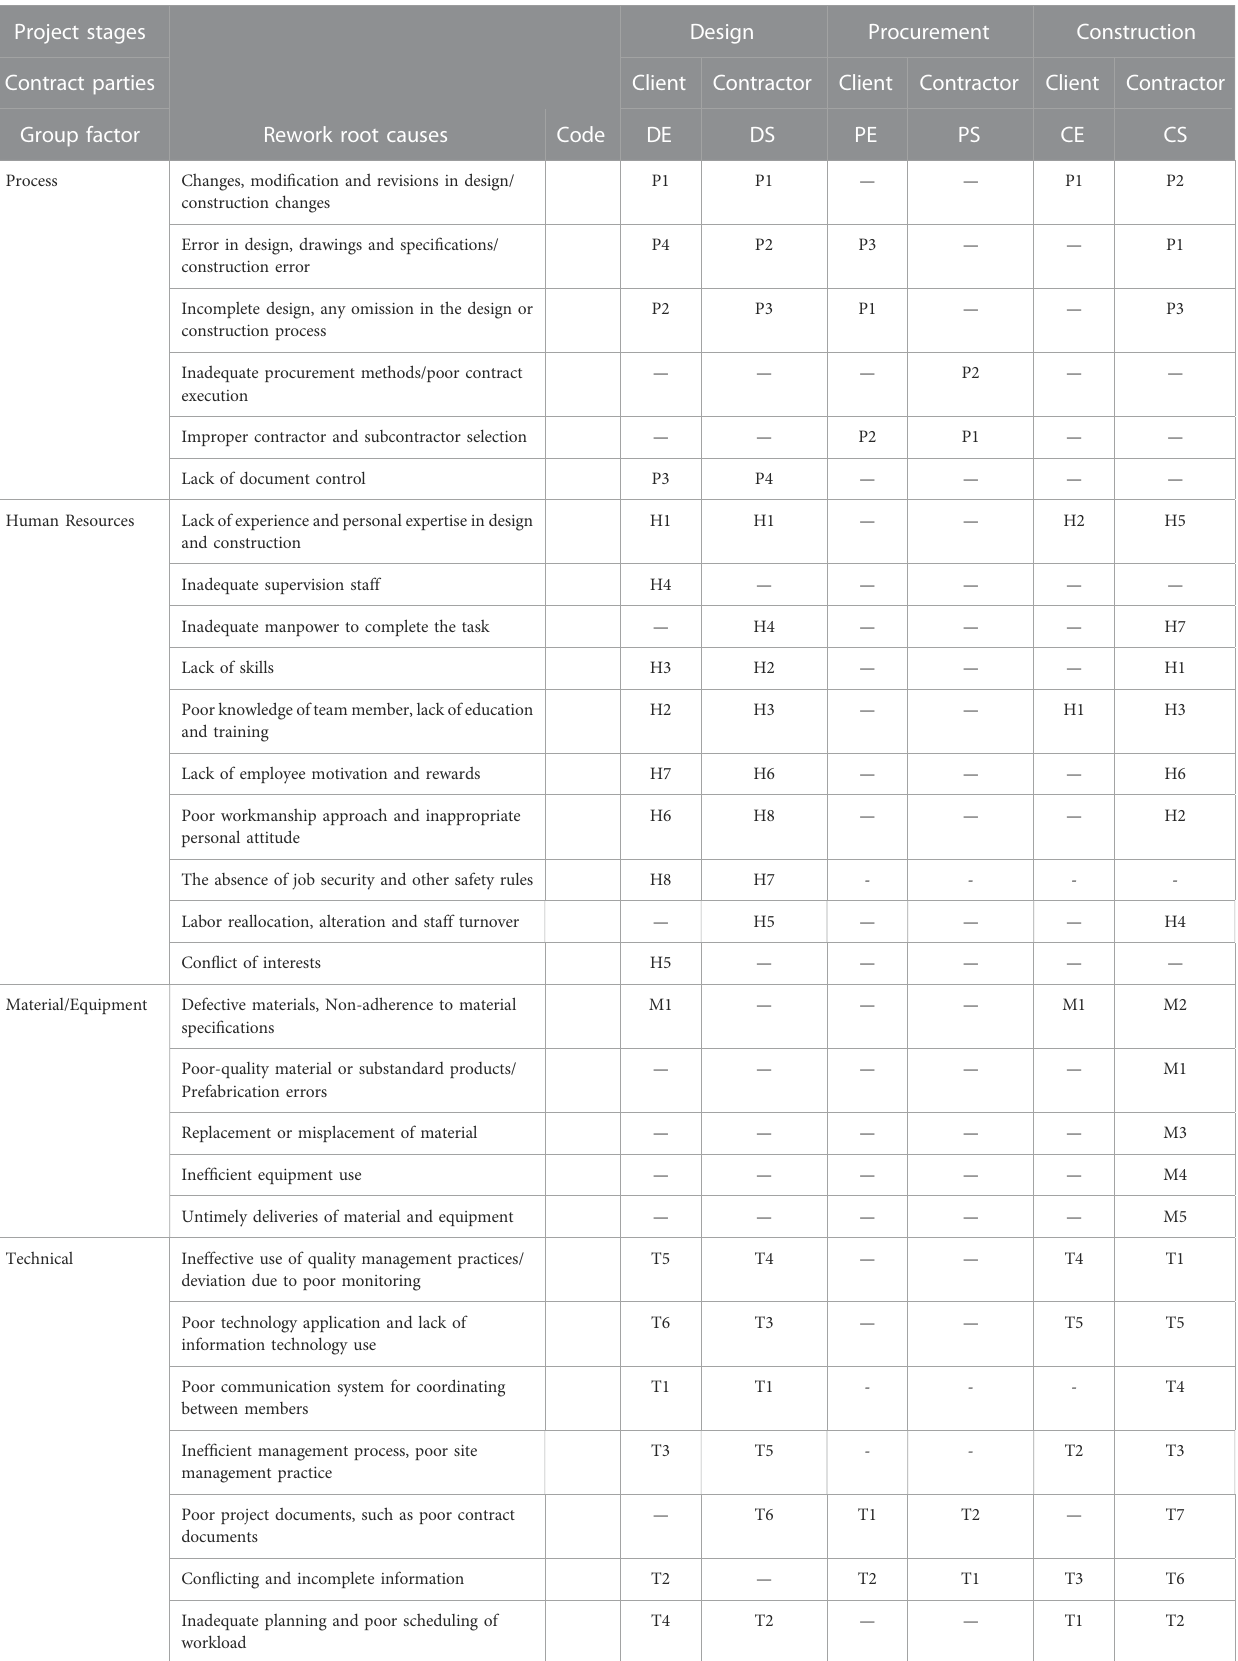
TABLE 8 List of rework causes in three stages of the project with liable contract